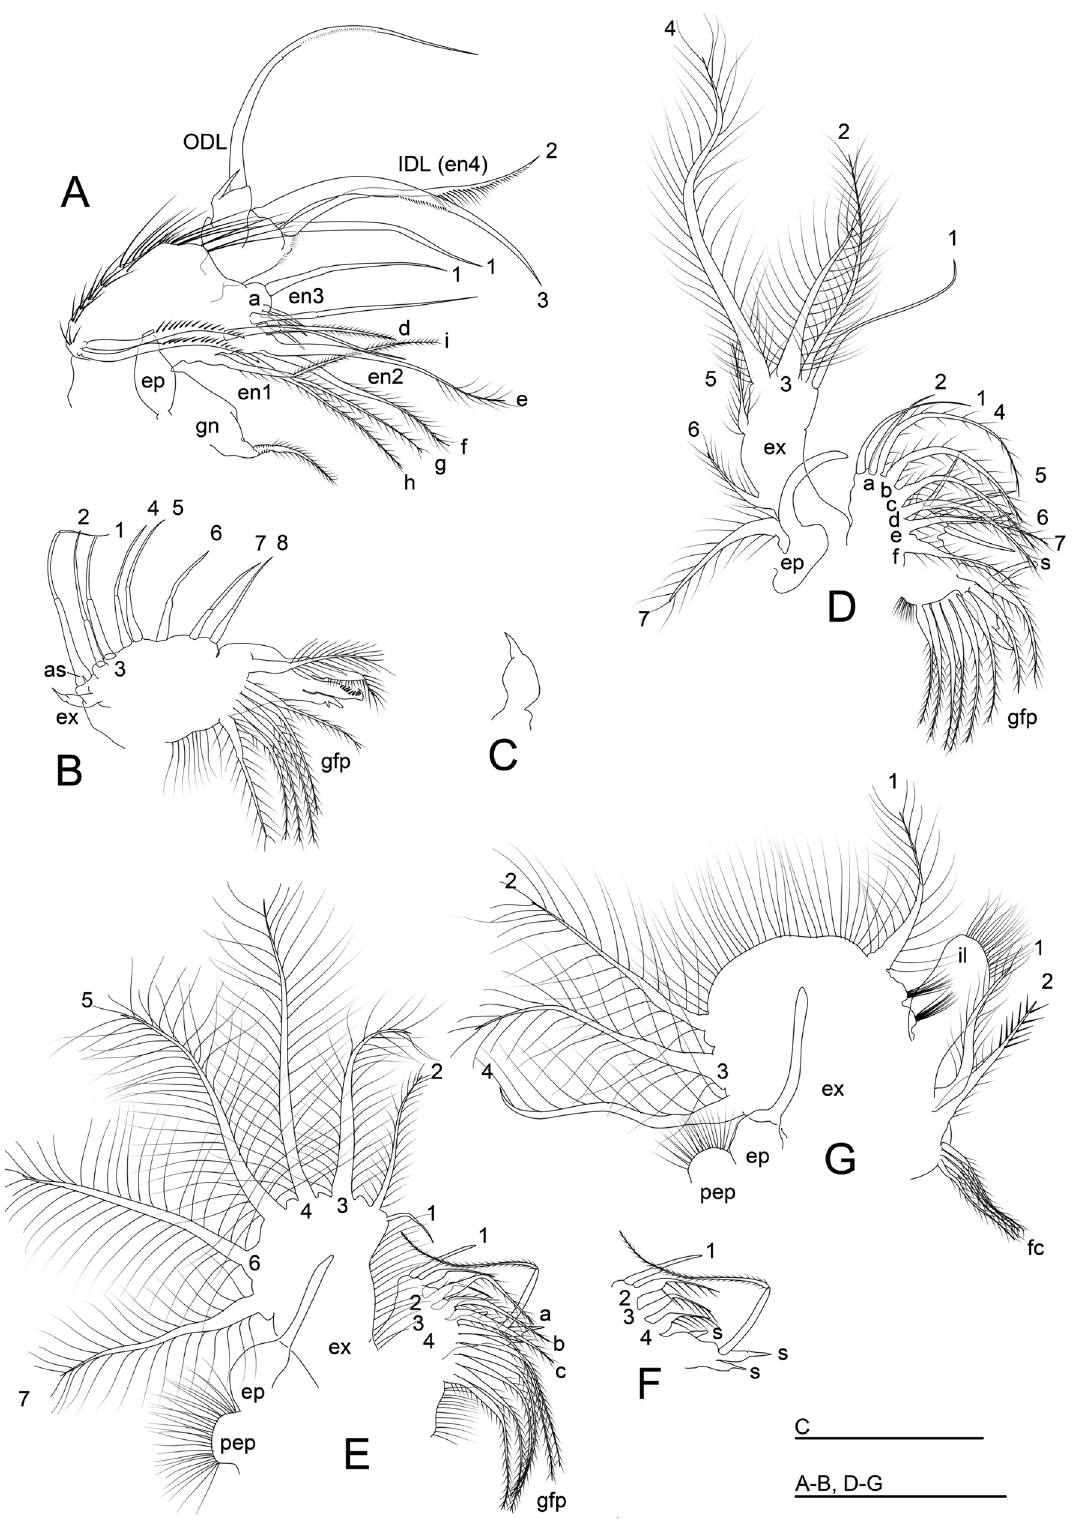
Fig. 2. Disparalona ( Mixopleuroxus ) leptorhyncha (Daday, 1905), parthenogenetic female. A . First limb. B . Second limb. C . Idem , exopodite. D . Third limb. E . Fourth limb. F . Idem , distal endite. G . Fifth limb. Scale bars = 50